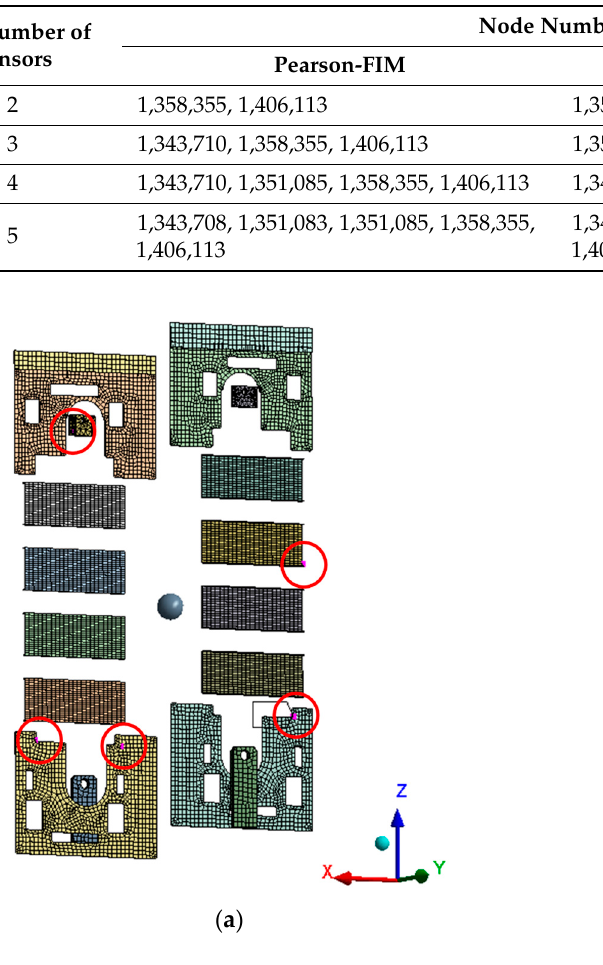
Figure 9. OSP Configuration: ( a ) Pearson-FIM; ( b ) Pearson-Efi. Table 5. OSP